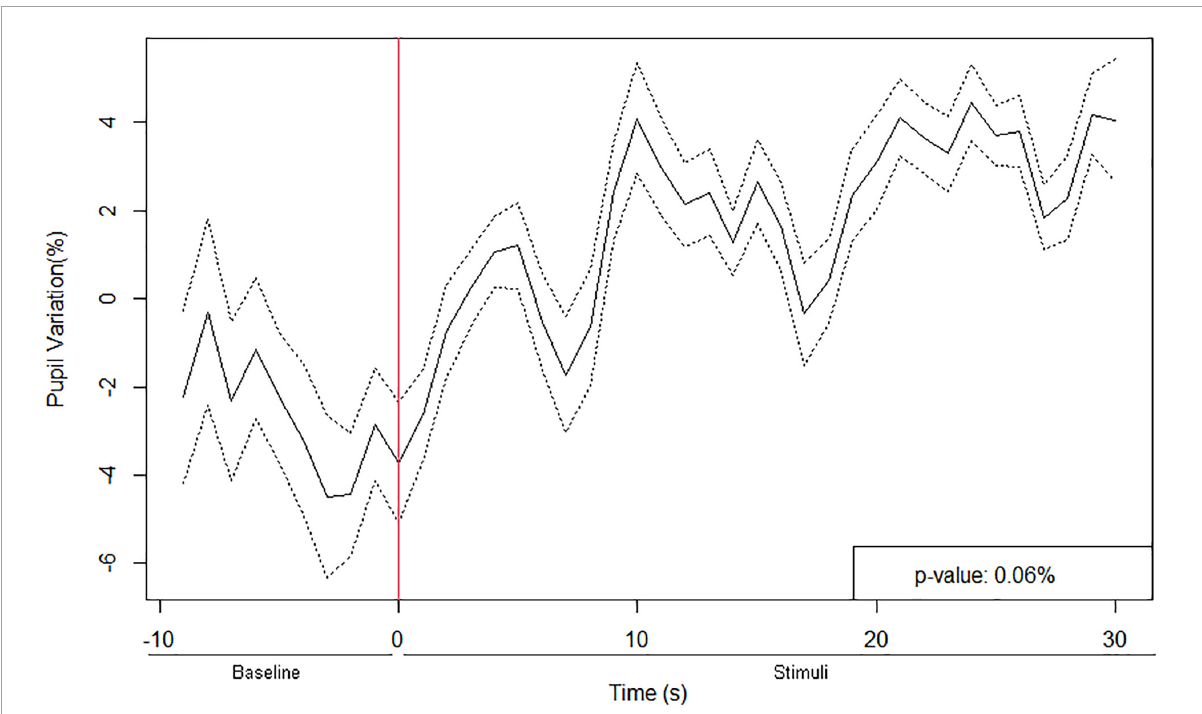
FIGURE3 Pupil diameter variation timeline during the MRT. The red line indicates the beginning of the task (stimuli), which had three different figures to rotate per block, yielding 30 s of stimuli ( p = 0.0006) and 10 s of baseline. The solid line indicates the mean ( µ ) and the dashed line indicates ± 1 standard error ( σ ).